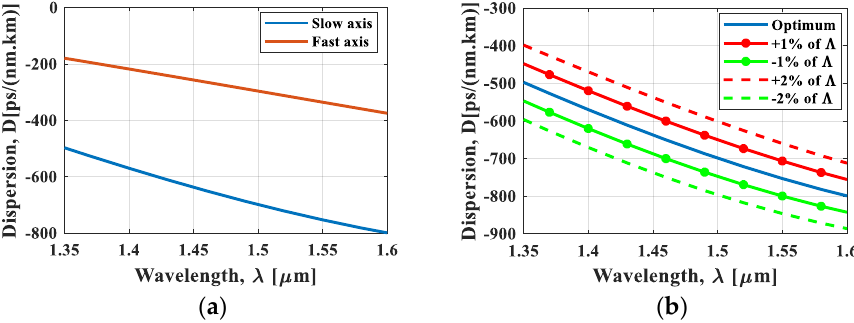
Figure 3. Effect of changing ( a ) d 1 / Λ on the birefringence characteristics, when the remaining parameters ( Λ = 0.76 and d 2 / Λ = 0.80) were kept constant; and ( b ) d 2 / Λ on the birefringence characteristics, when the remaining parameters ( Λ = 0.76 and d 1 / Λ = 0.95) were kept constant.